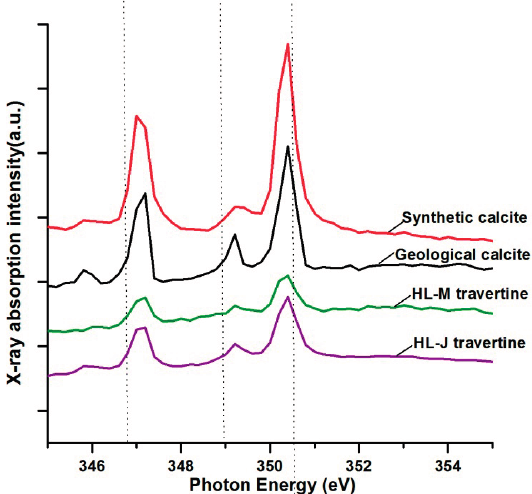
Figure 4. NEXAFS spectra measurement of Ca L control calcite. Spectrum of HL-M travertine represents sample of HLM-2. Spectrum of HL-J travertine represents sample of